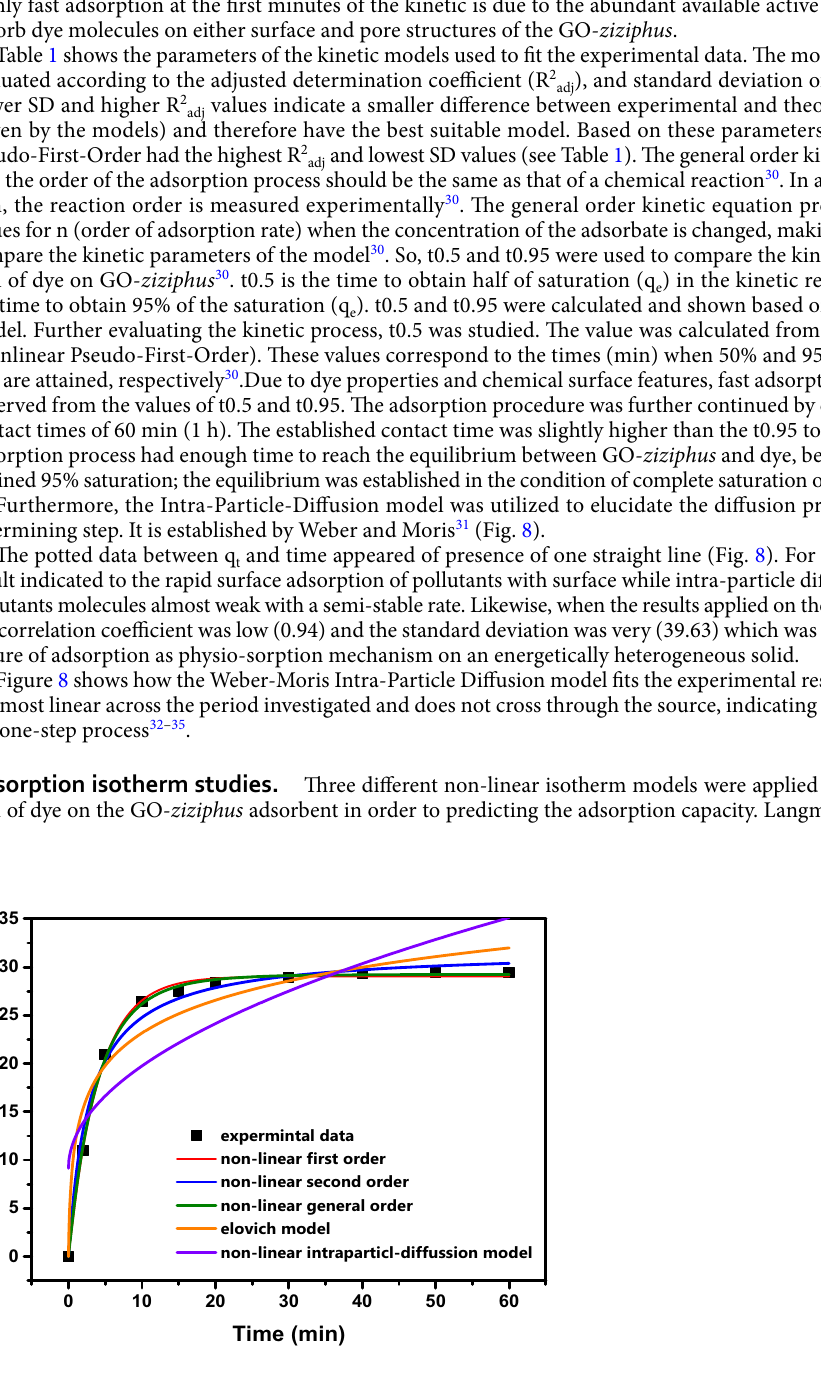
Figure 8. Adsorption kinetics models of nonlinear Pseudo-First-Order; nonlinear Pseudo-Second-Order, General order, Elovich and Intra-particle diffusion